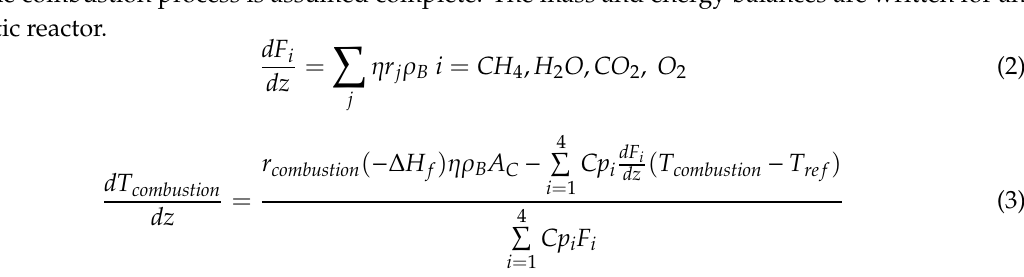
Figure 3. An elemental volume of the combustion chamber.